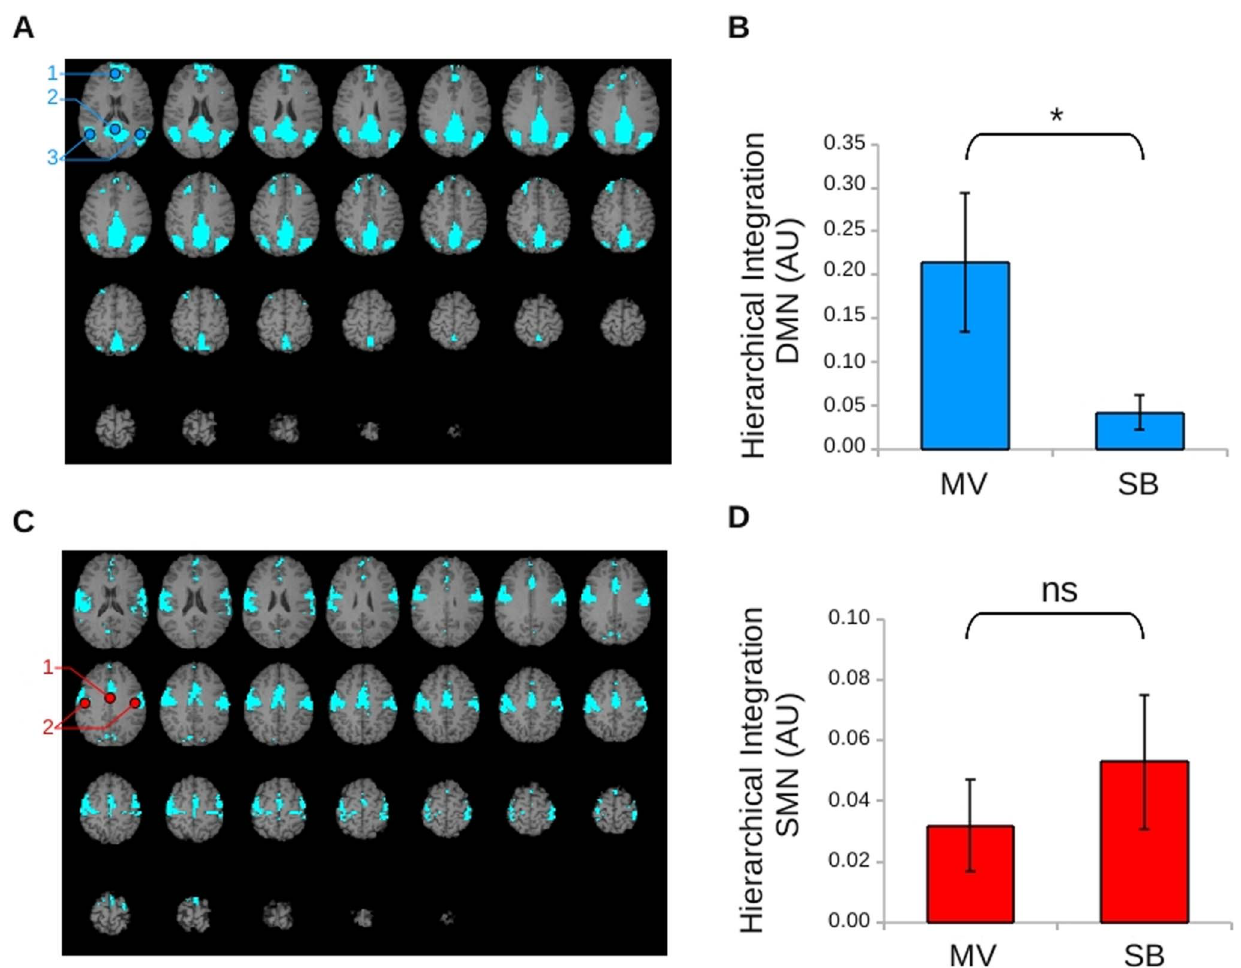
Figure 3. Functional MR connectivity assessed with an ICA method. (A).Default mode network (DMN): bilateral medial prefrontal and anterior cingulate cortices (1), bilateral precuneus (2), bilateral superior parietal cortices (3). (B).Mean values 6 standard deviation of DMN integrations for the mechanical (MV) and the spontaneous (SB) breathing blocks of resting state. The asterisk indicates a significant difference between conditions. (C). Sensorimotor network (SMN): bilateral supplementary motor area (1) and bilateral sensorimotor cortices (2). (D).Mean values 6 standard deviation of SMN integrations for the mechanical (MV) and the spontaneous (SB) breathing blocks of resting state. NS = non-significant difference between conditions; AU = arbitrary